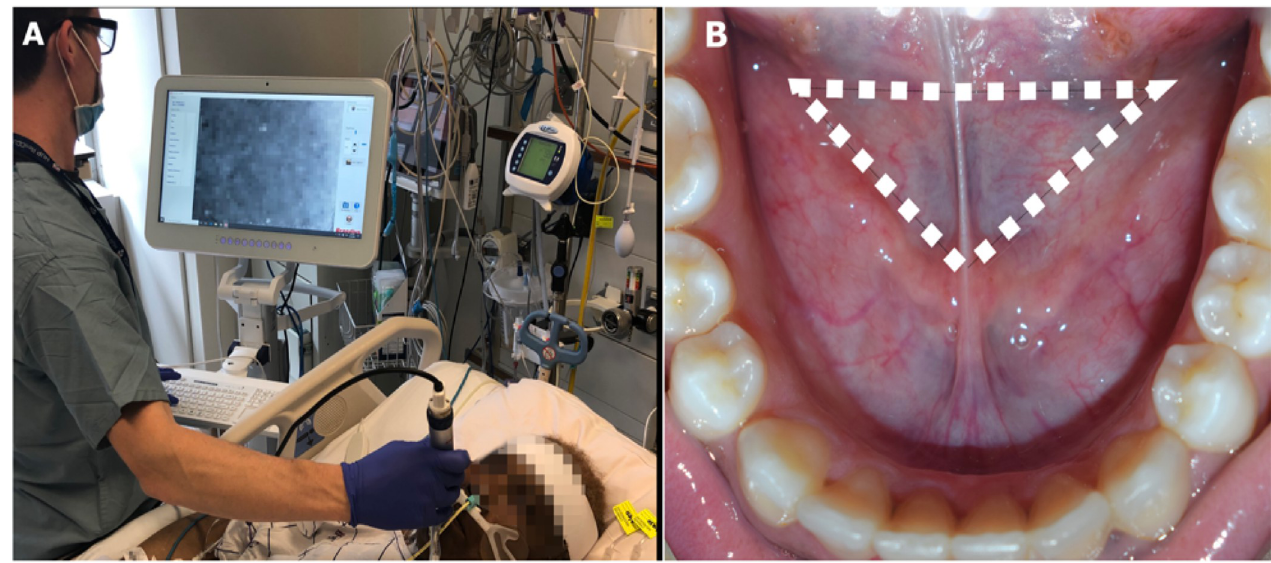
Fig 2. A. Experimental setup with patient in supine position during IDF measurement. B. Anatomical sublingual triangle where measurements are obtained.